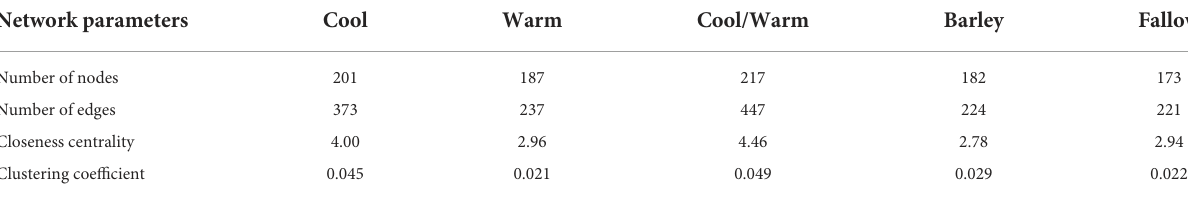
TABLE 5 Topological parameters of the bacterial co-occurrence networks for each treatment. Network parameters Cool Warm Cool/Warm Barley